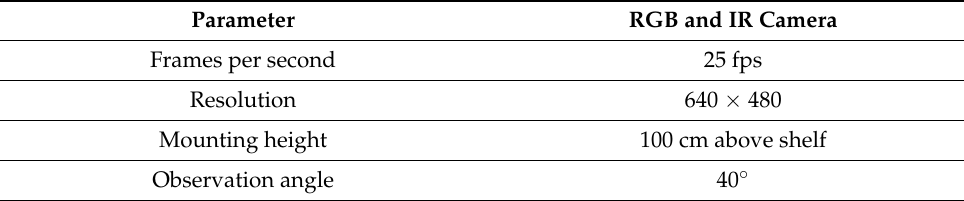
Figure 2. View in Rviz of recorded data during inspection. ( Top left ): depth camera data (gray) and lidar scan lines (red); ( top right ): front overview; ( bottom left ): depth camera data and lidar scan lines mapped onto 2D frontal view; ( bottom center ): RGB camera frame; ( bottom right ): IR camera frame (flipped horizontally). Table 1. Camera